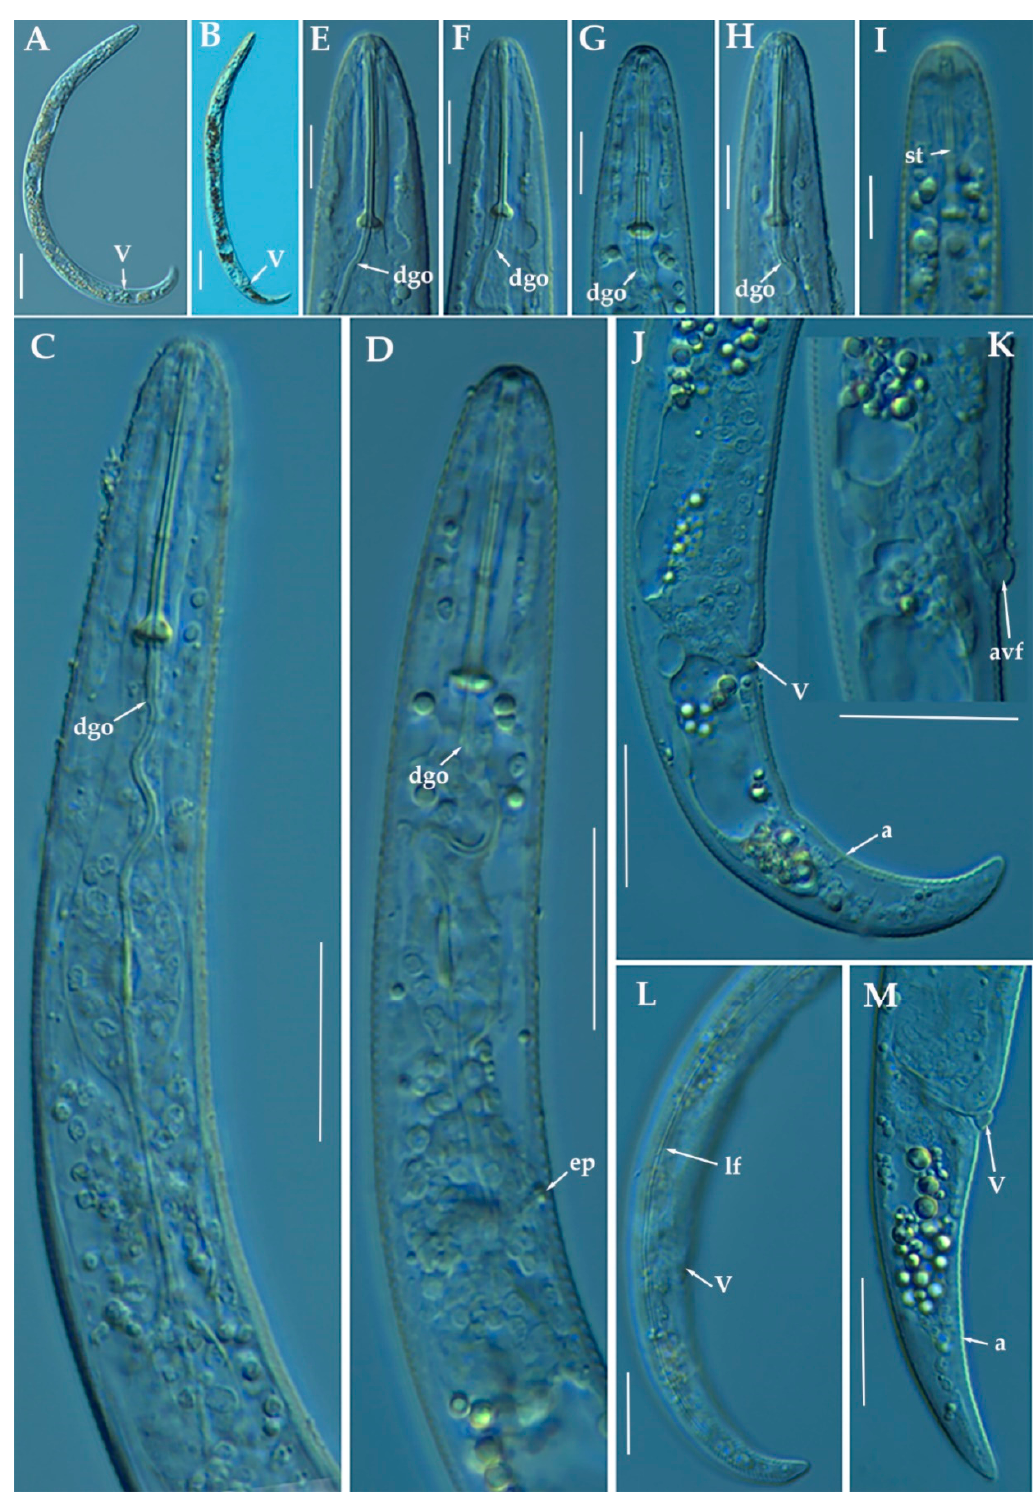
Figure 4. Light photomicrographs of female of Paratylenchus indalus sp. nov. ( A , B ): Entire female with vulva arrowed; ( C , D ): Female pharyngeal region; ( E – H ): Female lip region; ( I ): Fourth-stage juvenile showing stylet (arrowed); ( J ): Female posterior region with vulva and anus (arrowed); ( K ): Detail of vulva showing advulval flap (arrowed); ( L , M ): Female posterior region with lateral field, vulva and anus (arrowed). Scale bars ( A – D , J – M = 20 μ m; E – I = 10 μ m). (Abbreviations: a = anus; avf= advulval flap; dgo = pharyngeal dorsal gland orifice; ep = excretory pore; lf = lateral field; V = vulva).